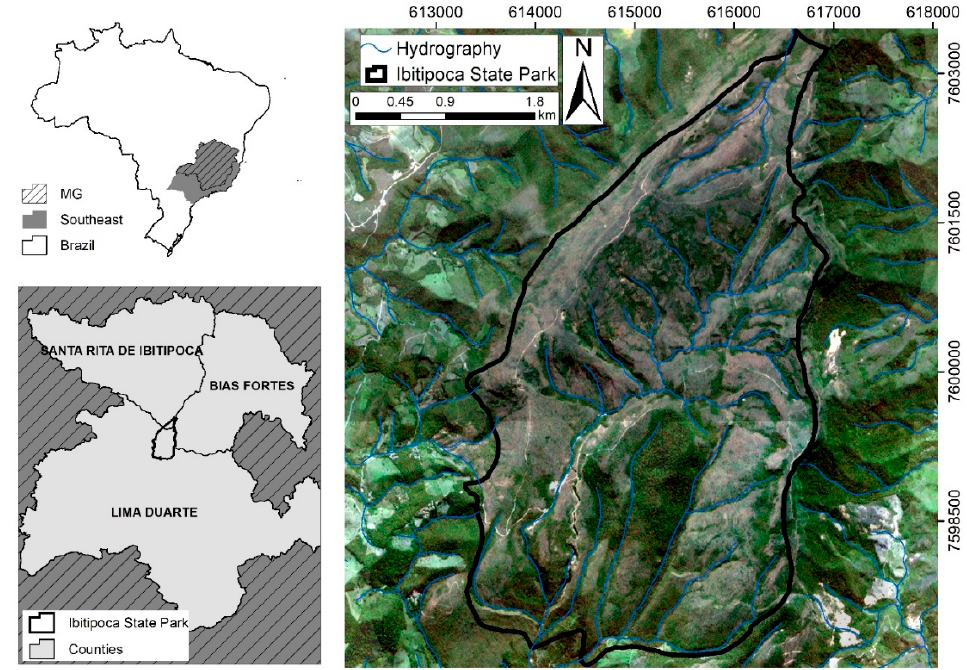
Figure 1. The study area (Ibitipoca State Park—ISP) and location in Brazil, Minas Gerais State